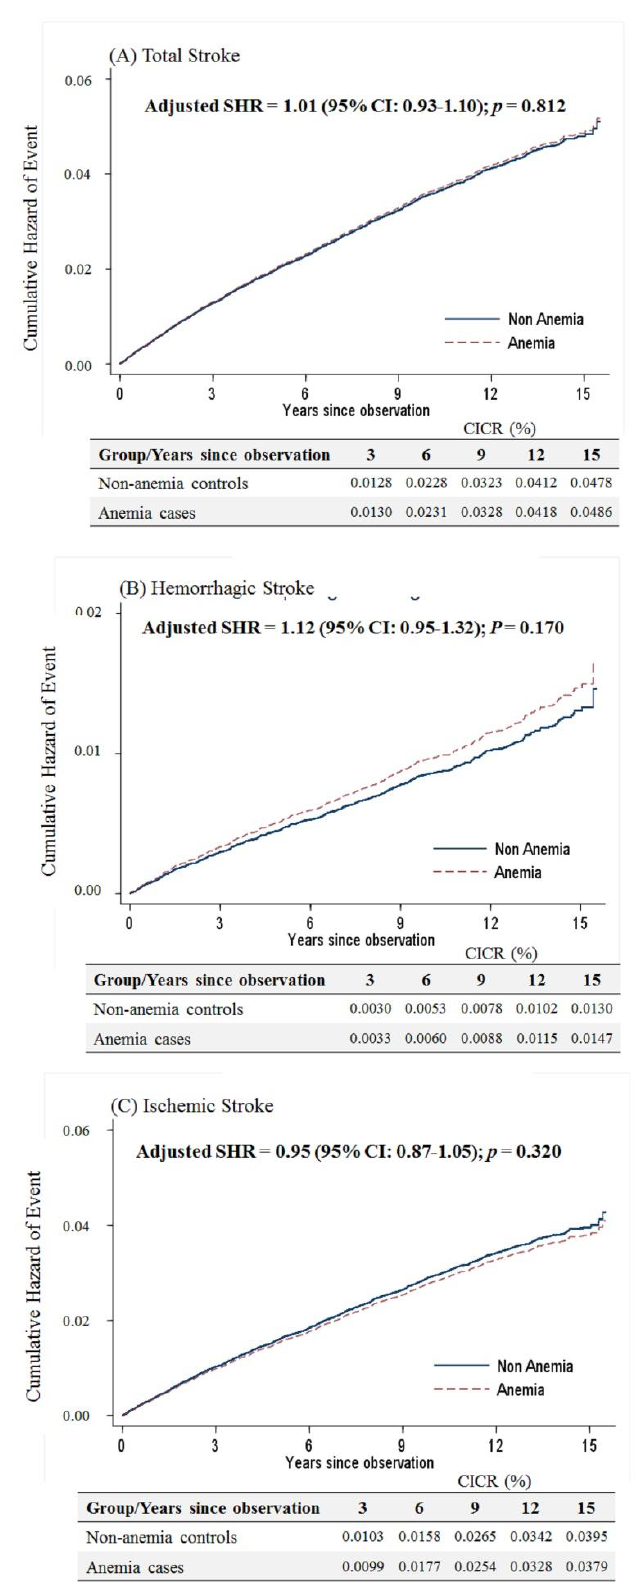
Figure 2. Cumulative incidences of competing risks (CICRs) of ( A ) total stroke, ( B ) hemorrhagic stroke and ( C ) ischemic stroke in anemia cases and non-anemia controls aged ≥ 50 years.